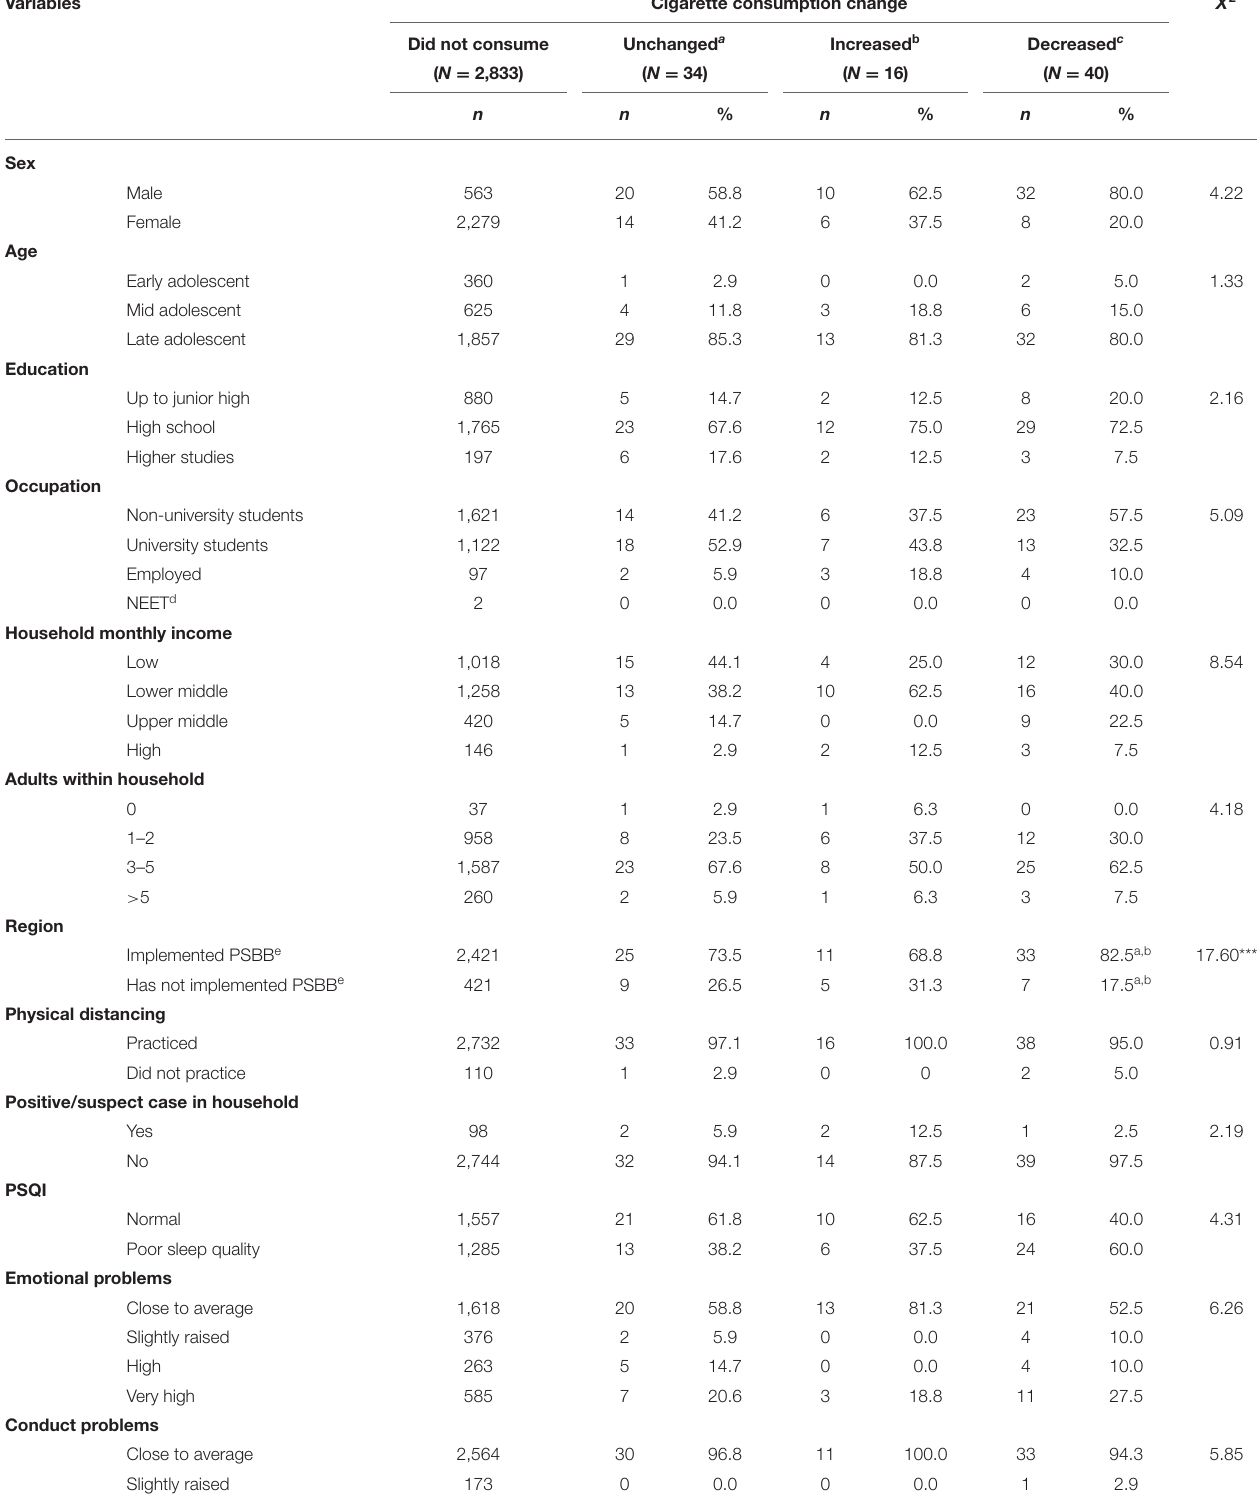
TABLE 3 | Descriptive data stratified by cigarette